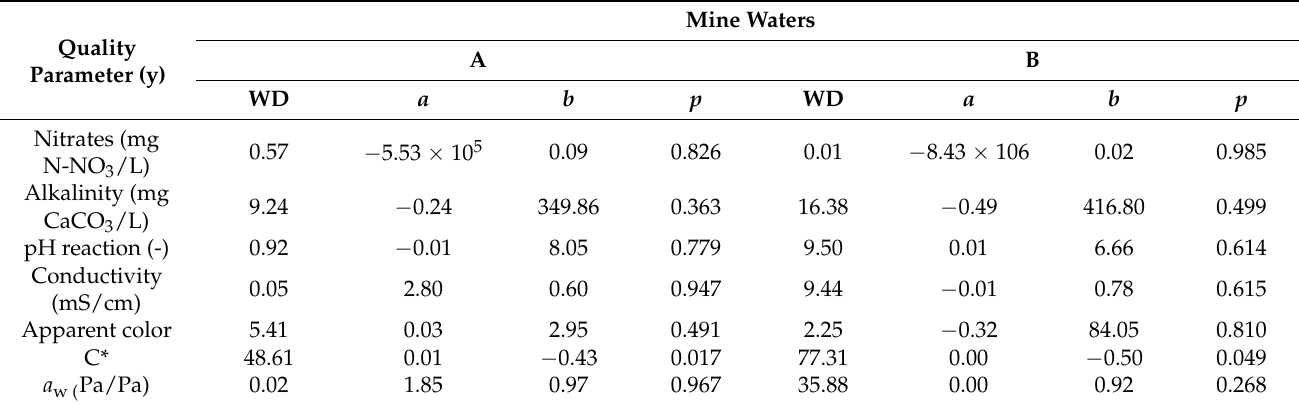
Table 3. Correlation between bioluminescence (x, RLU) and selected parameters of mine